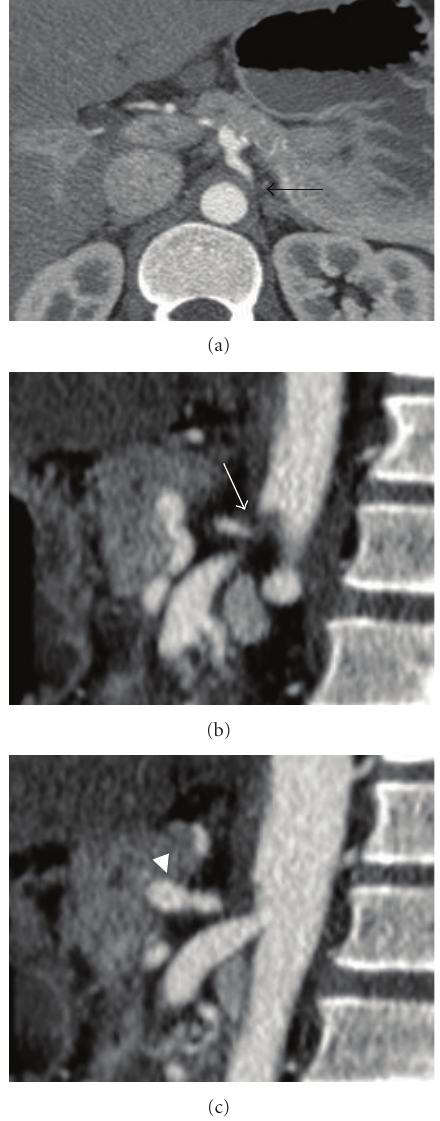
Figure 2: Axial (a) and sagittal (b and c) CT scans of MALS reveal severe stenosis of celiac axis from extrinsic compression (arrows) and poststenotic dilation of proximal celiac artery